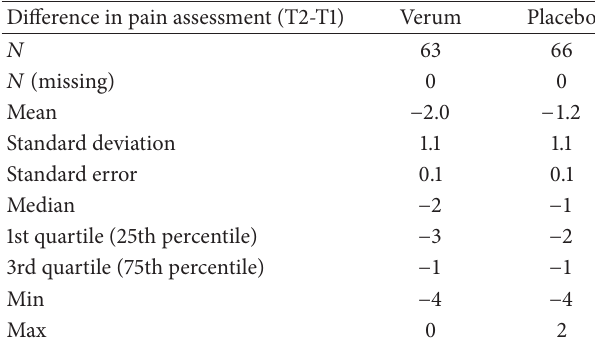
Table 2: Difference in pain assessment (T2-T1) (age group I [ ≥ 4